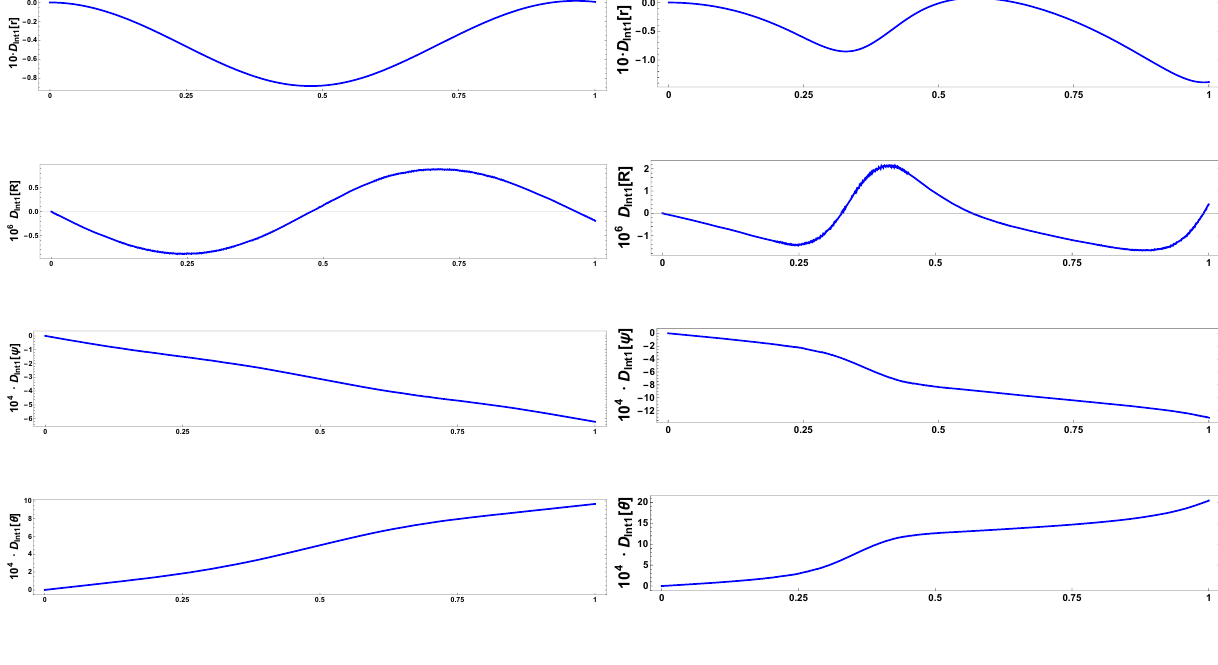
Fig. 4 Left column e = 0 . 1 and right column e = 0 . 5.Abscissas are orbital periods and D [ x ] = x Full − x Intermediary . The orbital period is 10.8 hours and r is expressed in Km, which initially is set to 1.560